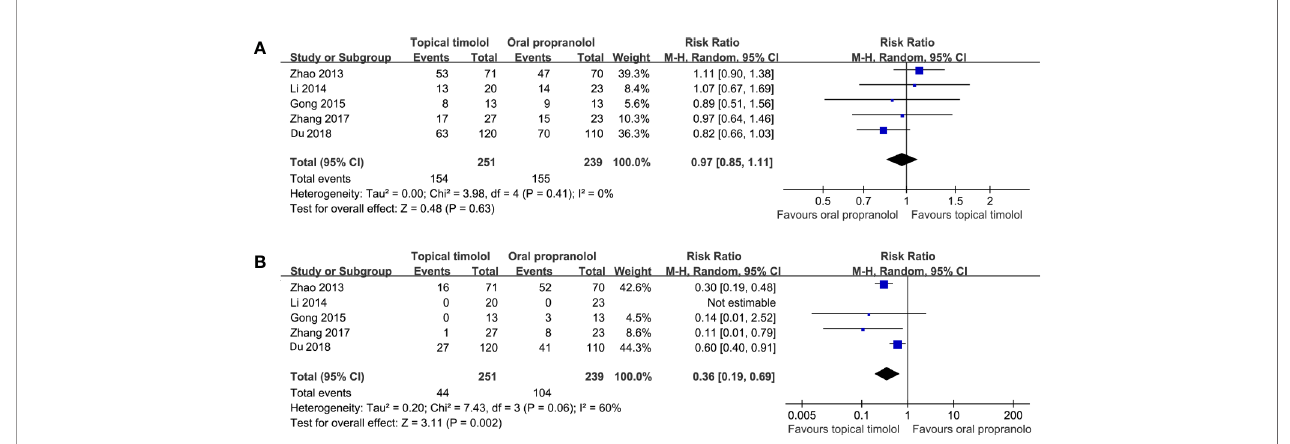
FIGURE 2 | Forest plots for the meta-analyses comparing the ef fi cacy and safety outcomes between topical timolol and oral propranolol for treating IH. (A) , response rate after treatment; (B) , incidence of adverse events.